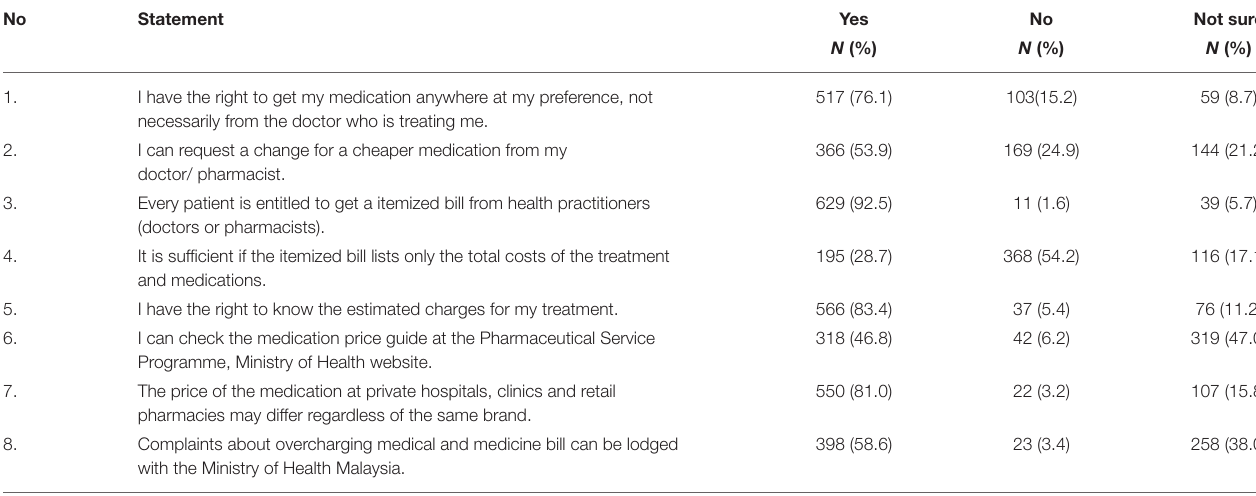
TABLE 2 | Respondents’ knowledge of medicine price transparency in private healthcare setting in Malaysia.